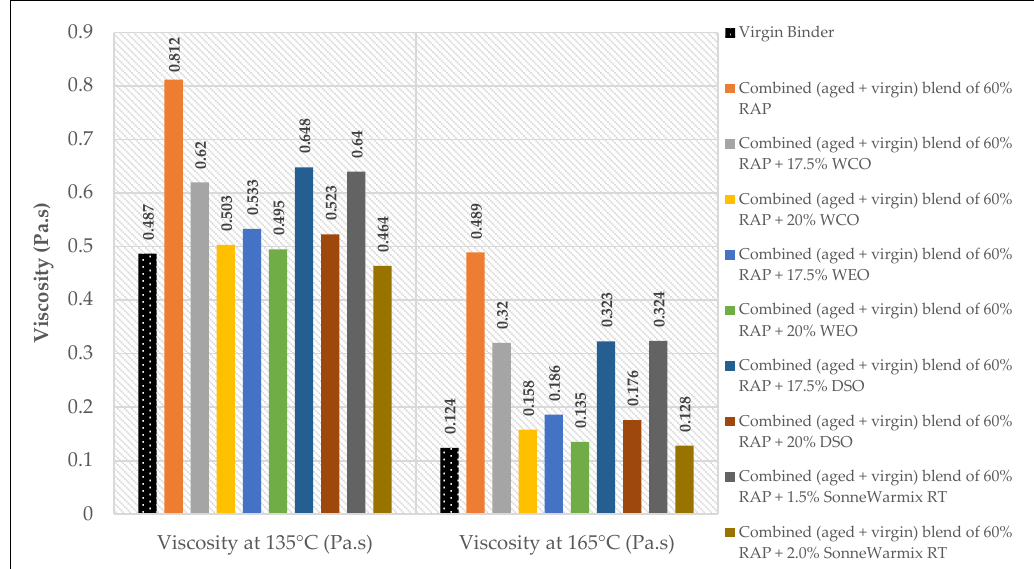
Figure 15. Rotational viscosity of combined (aged + virgin) binder blend of 40% RAP.